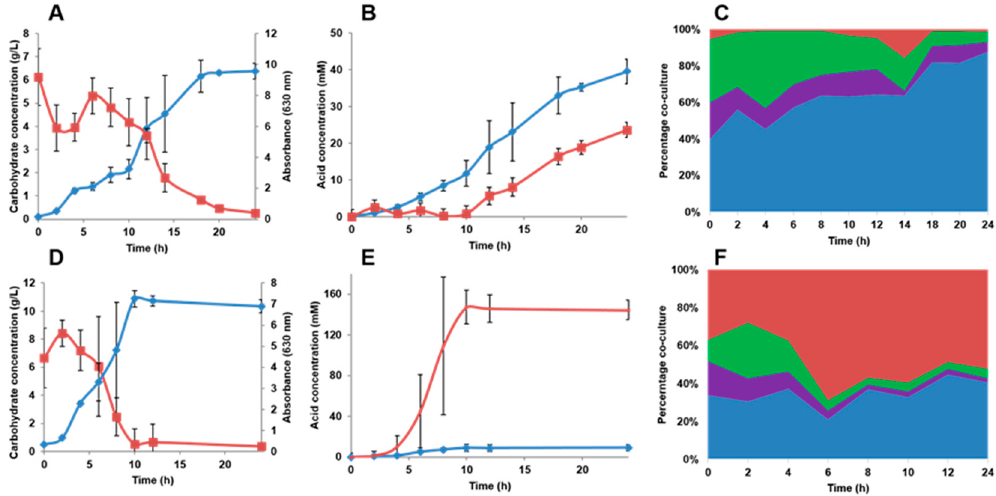
Figure 7. Batch cultures of the consortium in 2FL or FOS. Results represent the average of two 24 h fermentations. ( A , D ) Total biomass production (blue) and substrate consumption (red) during growth in 2FL or FOS respectively. Error bars indicate the standard error mean; ( B , E ) acetate (blue) and lactate (red) production in the fermentations using either 2FL or FOS; ( C , F ) relative abundance of each member of the consortium during growth in 2FL ( C ) or FOS ( F ). Red: L. acidophilus ; green: E. coli ; purple: Ba. vulgatus ; blue: Bi. infantis .